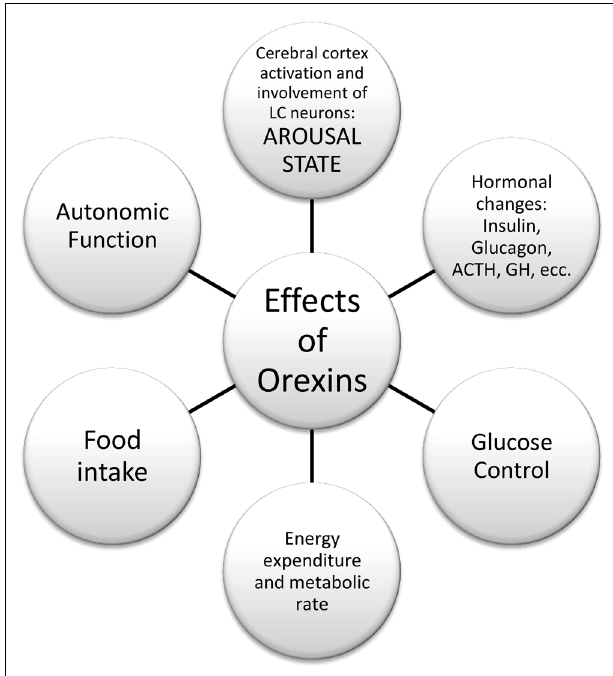
FIGURE 1 | Effects of orexins in peripheral tissue and central nervous system.